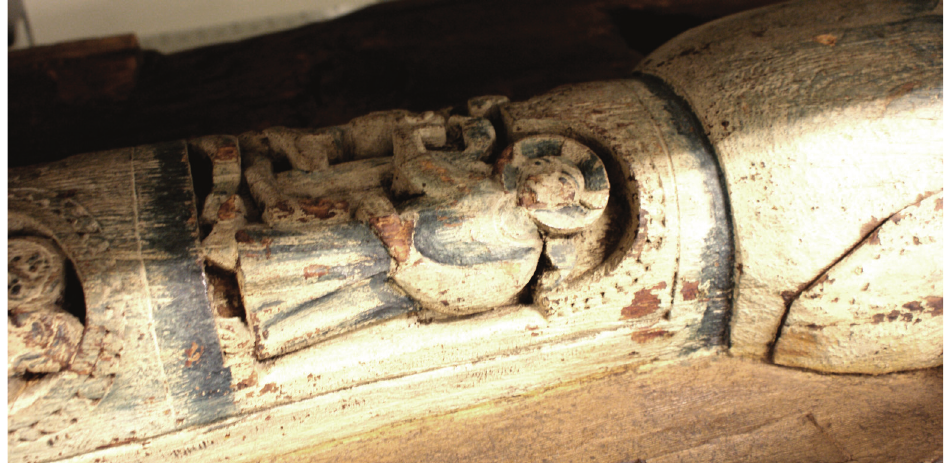
Figure 5: The topmost motif on the Nesland portal: The Creation, depicting a standing halo- wearing God creating Adam and Eve. Photo: